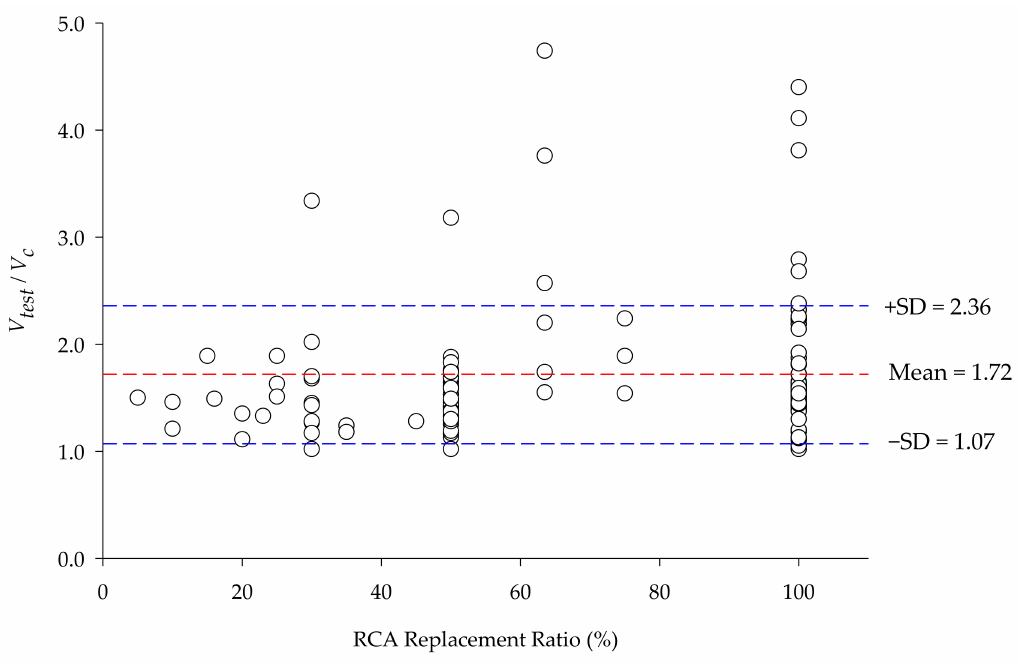
Figure 13. Evaluation of the proposed shear